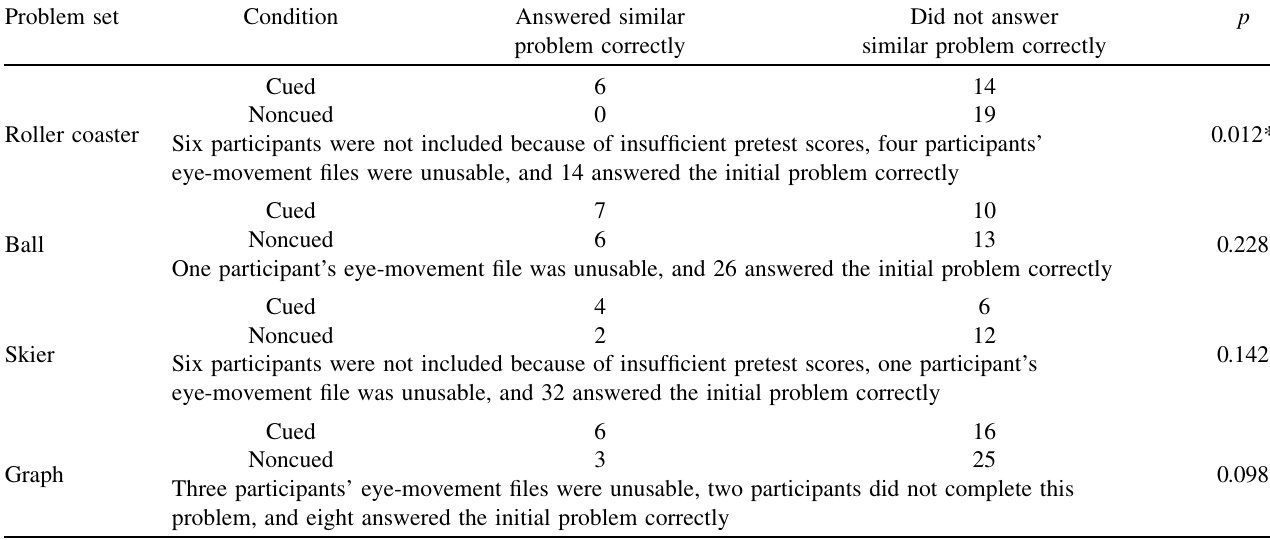
CAN SHORT DURATION VISUAL CUES . . TABLE I. Summary of results of Fisher’s exact test comparing those who did and those who did not answer a similar problem correctly for the cued and noncued conditions. An asterisk indicates a significant difference at the (cid:1) ¼ 0 : 05 level Problem set